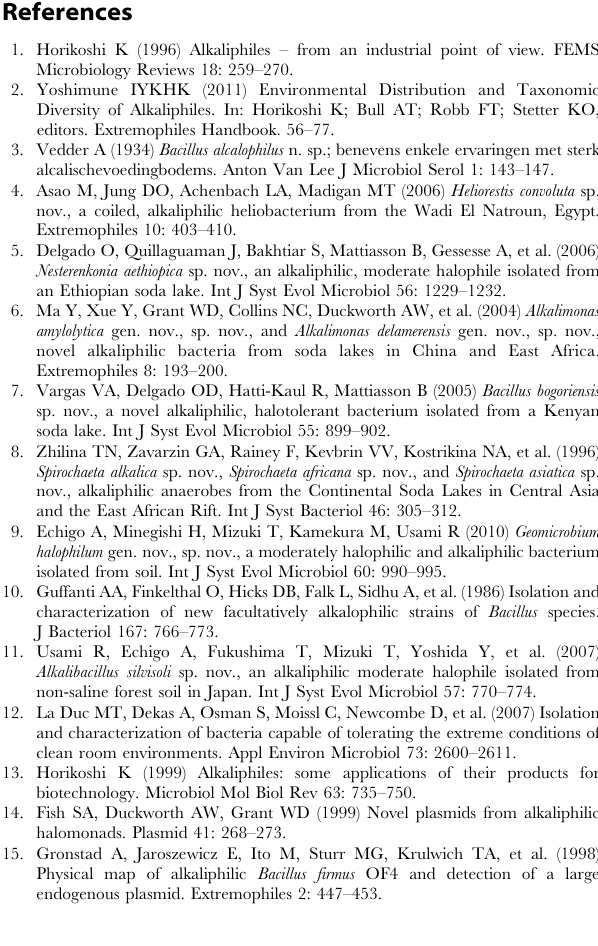
Figure S1 The cloning scheme of recombinant plasmids pGIAK13, pGIAK13A, pGIAK14 and pGIAK15. (A) pGIAK13 and pGIAK13A; (B) pGIAK14 and pGIAK15. The restriction enzyme sites used for each cloning are indicated. The predicted genes of plasmid pGIAK1 with different transcription directions are presented in blue and light green block arrows. The numbers beside the arrows correspond to the predicted genes encoded by